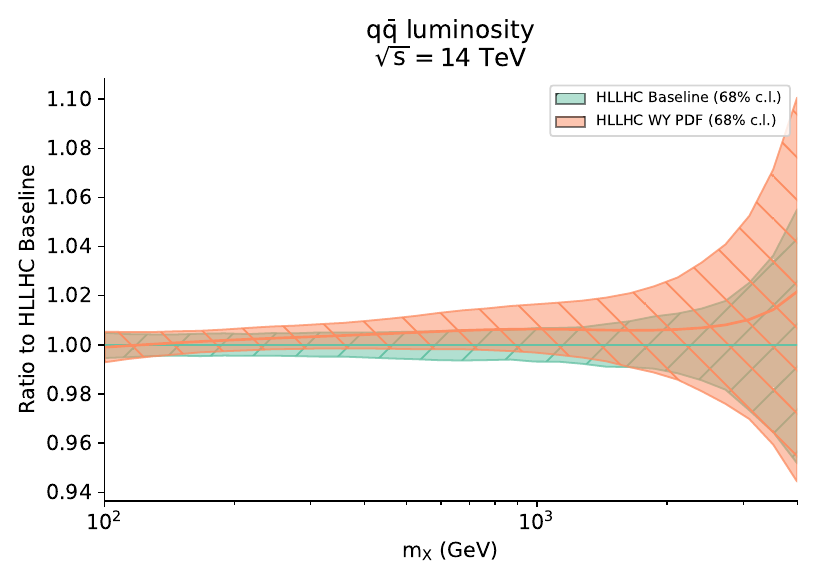
Figure 9 . q ¯ q luminosity channel of the PDF fitted in the presence of W and Y parameters fitted to the ATLAS and CMS high mass Drell-Yan data and the NC and CC DY HL-LHC projections, normalized to the appropriate baseline SM